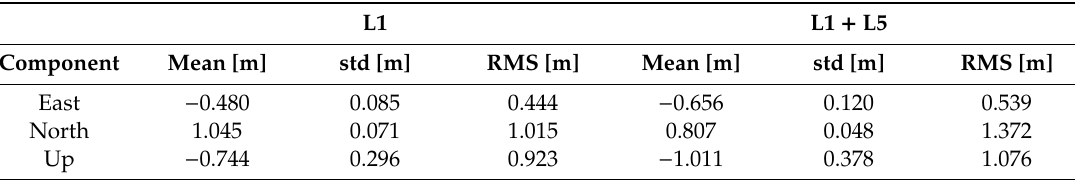
Table 8. Positioning results considering the GPS + GLONASS constellations. L1 + L5 frequencies are used only for GPS